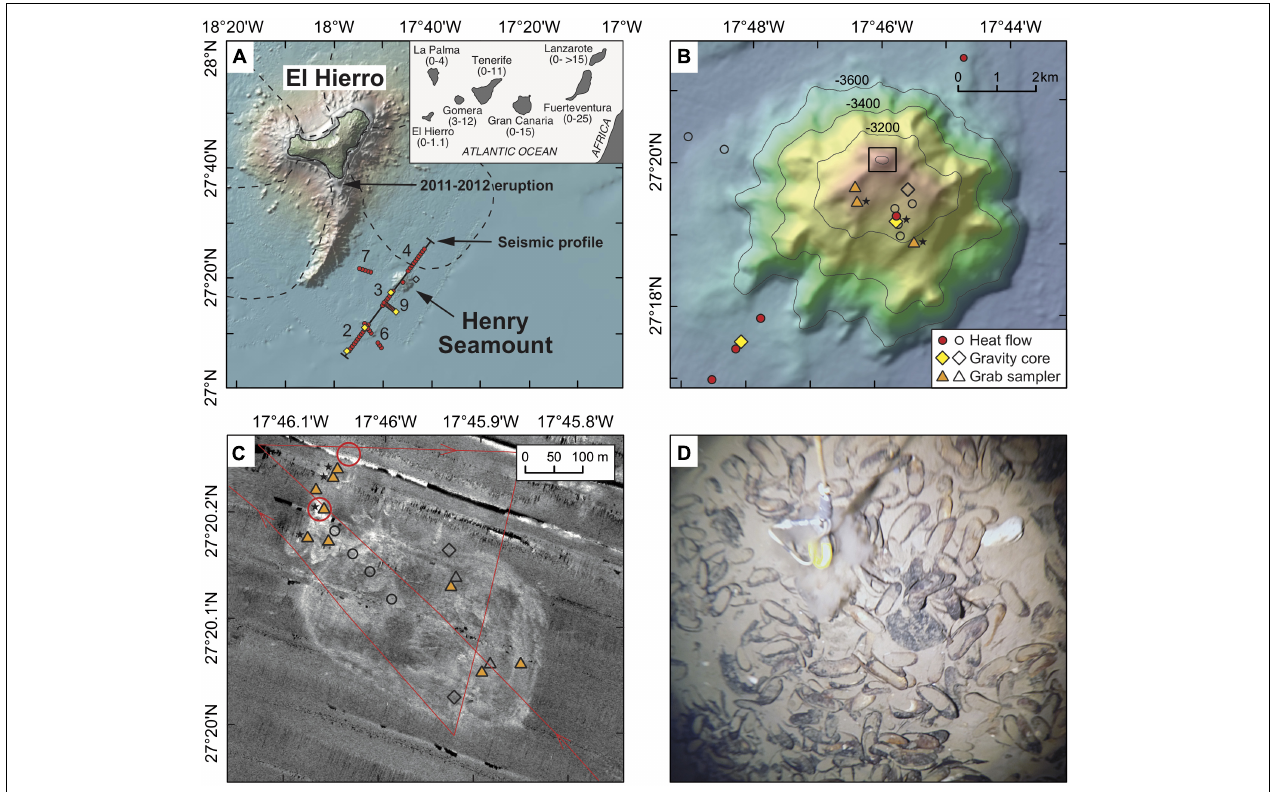
FIGURE 1 | (A) Location map of El Hierro and Henry Seamount, made with GeoMapApp (Ryan et al., 2009). Inset shows the Canary Islands, with numbers indicating the range of radiometric ages in Ma (from Geldmacher et al., 2005). Dashed lines outline landslide deposit boundaries after Gee et al. (2001). The line across Henry Seamount marks the seismic profile shown in Figure 4 , red circles indicate positions of successful heat flow measurements, numbers identify heat flow profiles (e.g., “2” for profile HF1802, etc.), and diamonds indicate gravity corer sites. (B) Bathymetric map of Henry Seamount with 200 m contours, showing sites where sediment samples were taken and heat flow was determined. Open symbols indicate unsuccessful attempts, and stars mark sites where tephra was recovered. Rectangle outlines the area shown in panel C . (C) High-resolution backscatter map of Henry Seamount’s summit area as obtained by AUV; symbols as in panel B . Red circles indicate localities of ORP anomalies shown in Figure 2 ; the corresponding TV-sled track is approximated by the red line. Areas with high backscatter (white-gray) indicate extensive coverage by clam shells or rock outcrops. (D) TV-sled photo from the summit area with vesicomyid clam shells up to 20 cm in size. Field of view is approximately 1 × 1